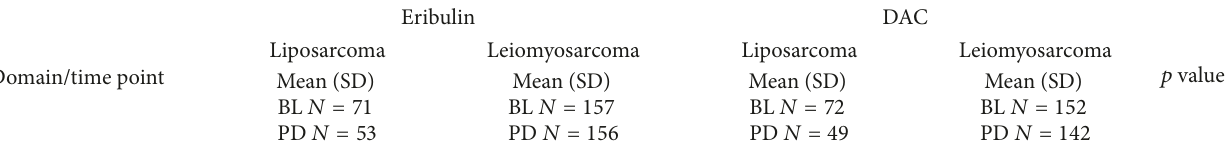
Table 3: Adjusted mean values at baseline and progression stratified by treatment and